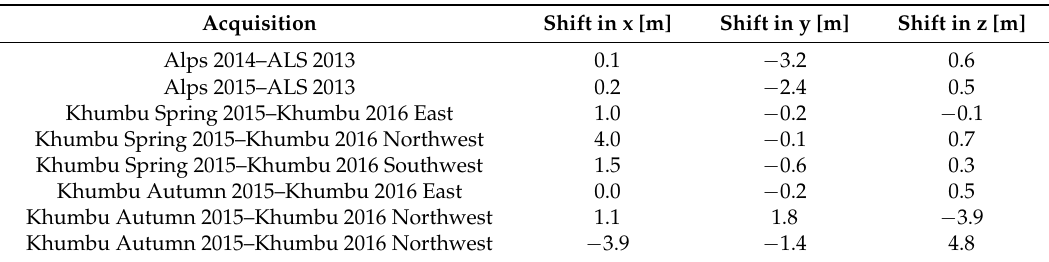
Table 2. Shifts of the slave DEM in relation to the master DEM calculated during the co-registration process. Multiple values for the Khumbu Himal study area are due to the three triplets needed to cover the whole study area. ALS: airborne laser